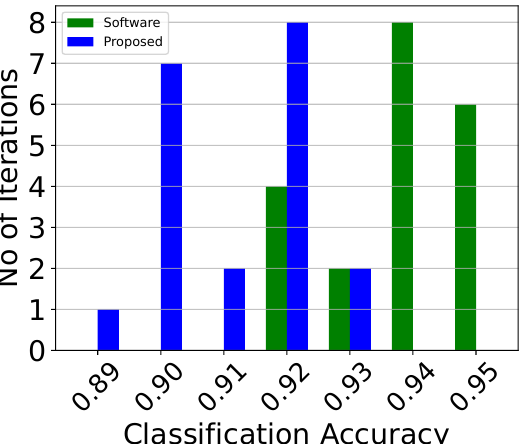
Figure 11. Classification accuracy histogram of the analog voting classifier over 20